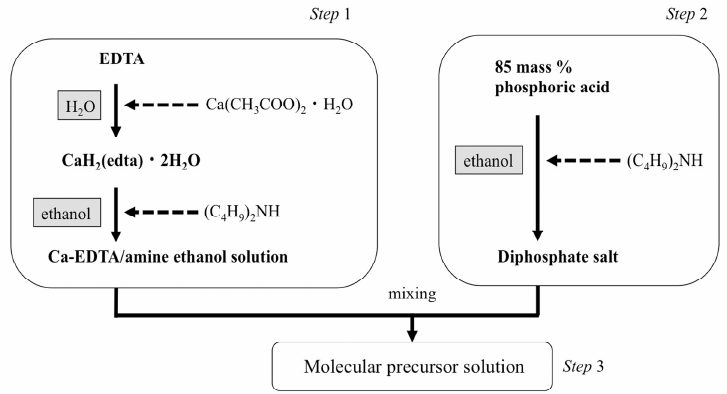
Figure 1. Preparation steps for the molecular precursor solution.